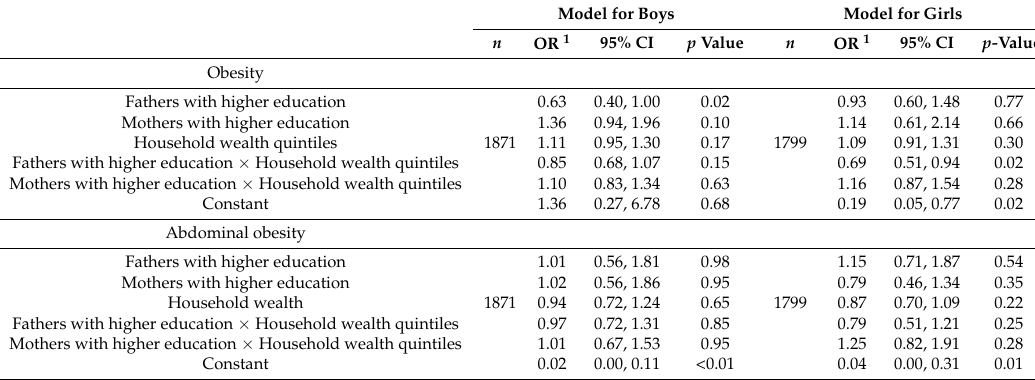
Table 6. Interaction between parent education and household wealth quintiles on obesity and abdominal obesity risk separated by sex. Model for Boys Model for Girls